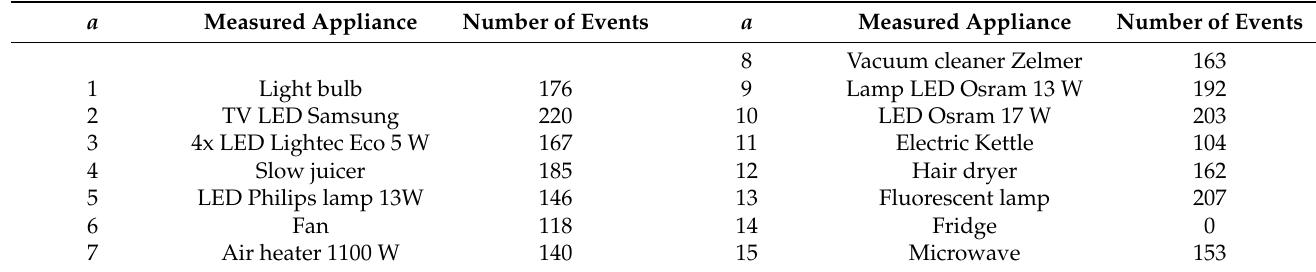
Table 1. Characteristics of the electrical appliances (EAs) selected for